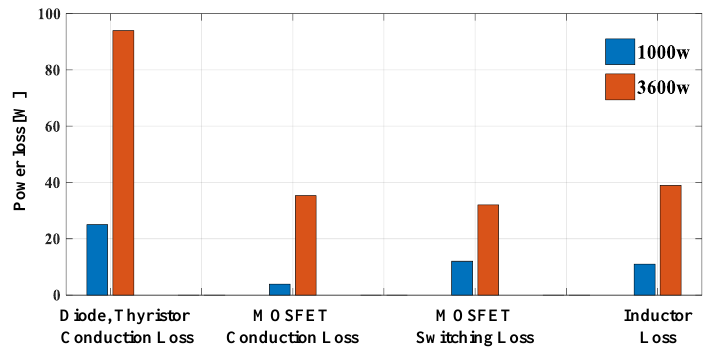
Figure 15. Loss breakdown at the output power of 1000 and 3600 W.